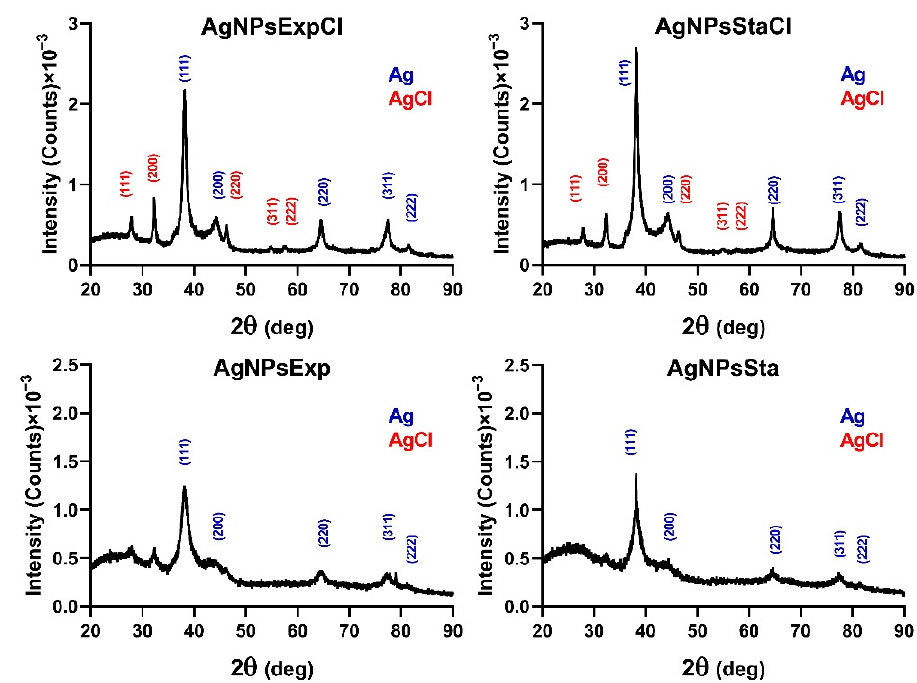
Figure 4. Nanoparticles’ crystallinity determination. XRD patterns of the AgNPs with the indicated planes of Ag 0 (blue) and AgCl (red) crystals.